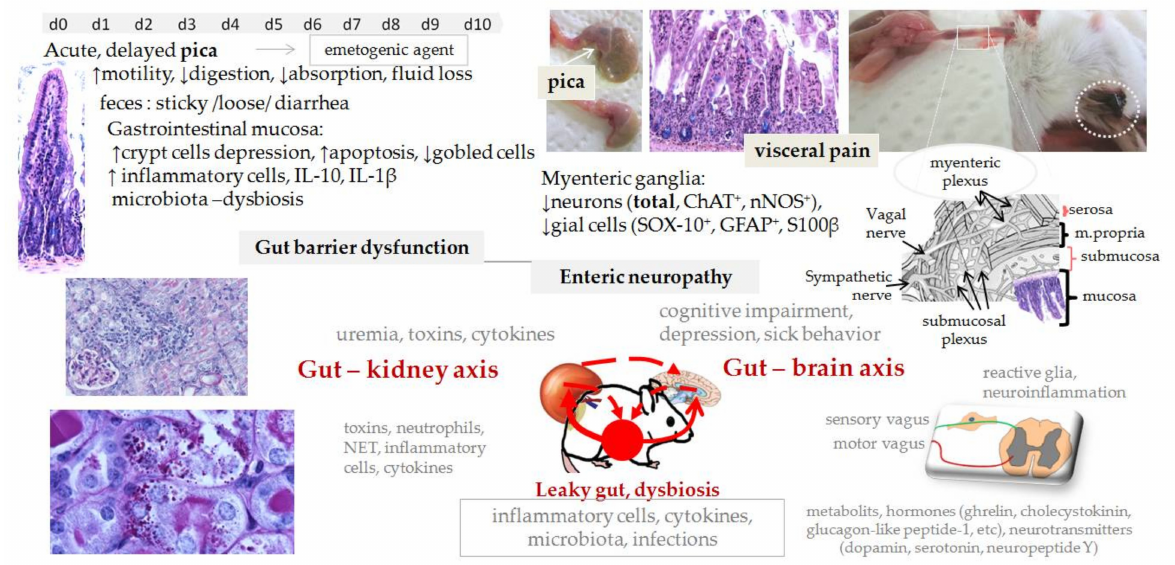
Figure 2. Cisplatin causes acute and chronic effects in the gastrointestinal tract. A single injection of cisplatin causes pica, a rodent-specific behavior of nausea, which reflects as a progressive reduction in food intake, increase in non-nutritive material intake (for instance bedding) and decreased gastric motility [107]. As a result the stomach is full of bedding and markedly enlarged/distended (white arrow) [114]. Reduction in food (68%) and water intake (45%) and an increase in stomach content (threefold) is evident from day 2 on (C57BL/6; 6 mg/kg ip) [114]. First morphological changes in the small intestinal mucosa (i.e., apoptosis, necrosis, decreased number of goblet cells, shortened villi and inflammatory cell infiltration) can be seen 1 day after a single cisplatin injection (B6D2F1: 8 mg/kg, 10 mg/kg, 12 mg/kg, 14 mg/kg; ip; d1,3,6,10,14) followed by reduced mucosal digestive function (depletion in maltase, sucrose, disaccharidase activity and reduced absorption) [108,115]. Depression in crypt cell production is already evident 2h after cisplatin and is maximal between 12 and 24 h post-treatment (CBA: 10 mg/kg, ip). Cisplatin causes lesions also in the colon mucosa, however, they appear later and are less severe [72]. The severity of gastrointestinal damage and mucosal dysfunction is dose-dependent and can persist up to 10 days after a single sub-lethal dose of cisplatin (B6D2F1: 8 mg/kg, 10 mg/kg, 12 mg/kg, 14 mg/kg; ip; d1,3,6,10,14) [72]. Mucosal recovery is slow, first signs of recovery can be observed 7 days post-treatment [72]. Repeated cisplatin administration (C57BL/6; 4 mg/kg/week for 4 weeks, ip; ↓ 20% BW) besides gut lesions ( ↑ IL-1 β and IL-10) also causes delayed pica, [55] and alterations in the ENS seen as loss of neurons in the myenteric ganglia of mouse gastric fundus (total and nNOS + ) [56] and colon (neurons (total, ChAT + , nNOS + ) and gial cells (SOX-10 + , GFAP + , S100 β + ) [55]. Circulation and the nervous system are the main pathways for communication between the gut, the kidney and the brain in health or disease (the brain–gut–kidney axis). Legend: BW—body weight; ChAT—choline acetyltransferase; ENS—enteric nerve system; GFAP—glial fibrillary acidic protein; NET—neutrophil extracellular traps; nNOS—neuronal nitric oxide synthase;